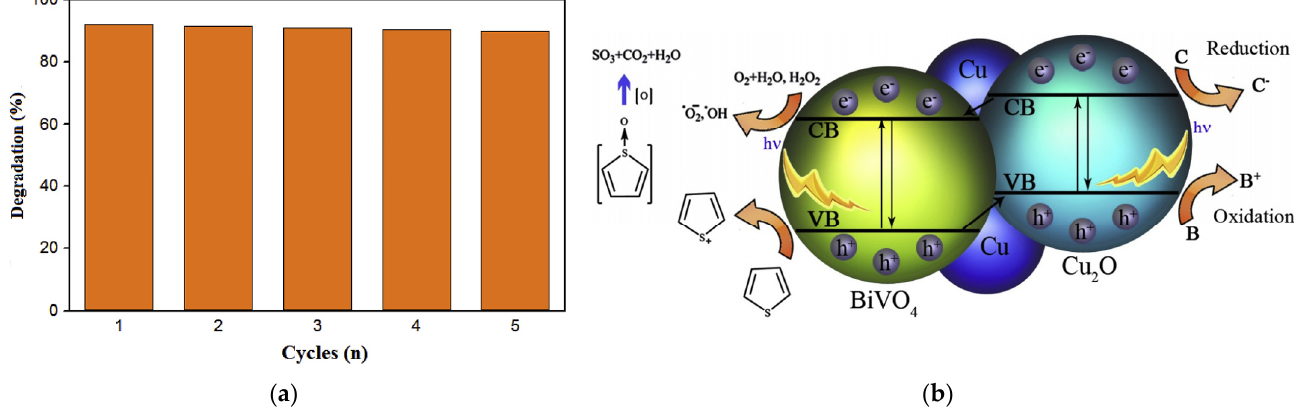
Figure 8. ( a ) Stability of the Cu/Cu 2 O/BiVO 4 photocatalyst. ( b ) Mechanism of PODS on Cu/Cu 2 O/BiVO 4 . Reproduced from ref. [99] with permission from Elsevier. Copyright 2020 Elsevier.